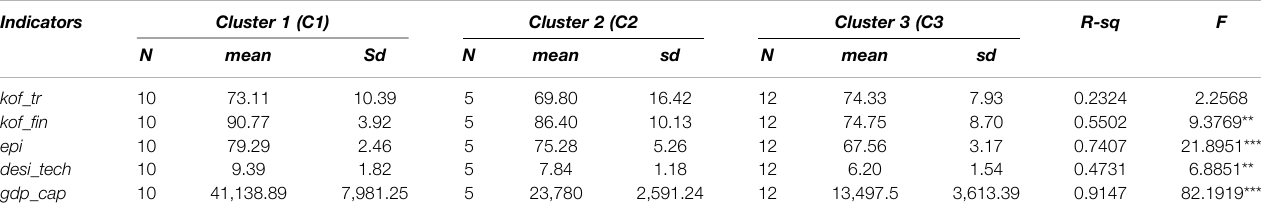
TABLE 6 | Cluster analysis results (Ward method).